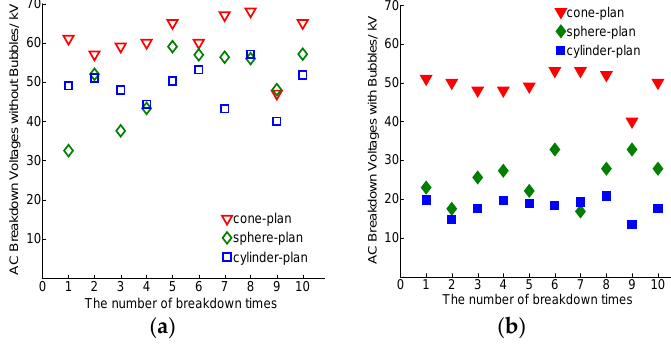
Figure 3. The AC breakdown voltages (effective values) of the transformer oil. ( a ) The AC breakdown voltages of the oil without bubbles; and, ( b ) the AC breakdown voltages of the oil with bubbles.